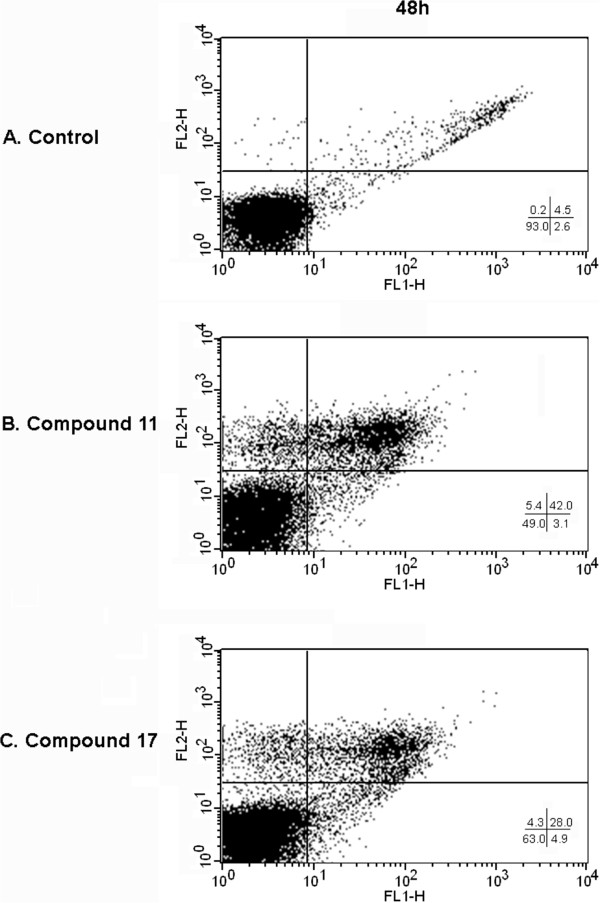
Effect of indirubin analogues 11 and 17 on the cell-death ofL. donovanipromastigotes. Effect of compounds 11 (B) and 17 (C) on the cell-death of L. donovani promastigotes, incubated with the GI50 of each compound for 48 hrs. Cells were stained with AnnexinV-FITC (horizontal axis, FL1-H) and propidium iodide PI (vertical axis, FL2-H) to assess membrane fluidity perturbations (AnnexinV staining) and membrane impermeability. The samples were then analyzed by flow cytometry. DMSO was used as negative control (A).